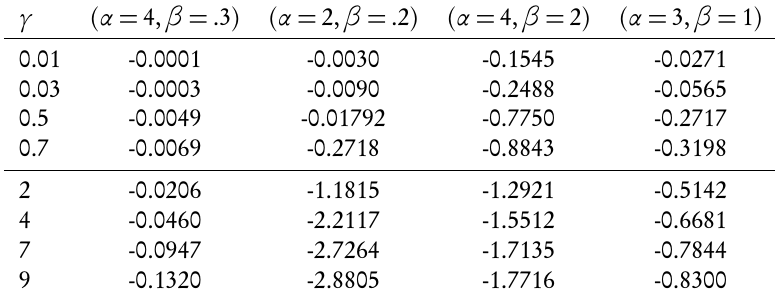
Numerical Computation of the Renyi Entropy of the MOEUGD ( λ =